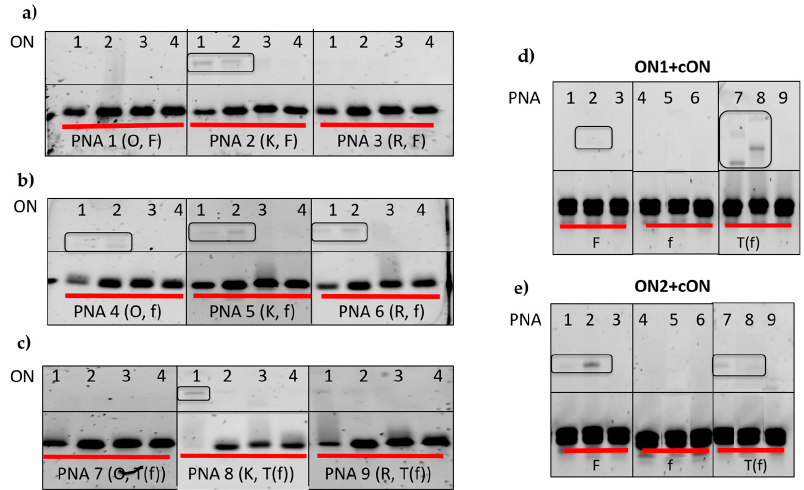
Figure 4. Denaturing polyacrylamide gel electrophoresis analysis of the crosslink experiments. ( a ) Crosslink experiment between ON 1 – 4 and PNA 1 – 3 (building block F ); ( b ) Crosslink experiment between ON 1 – 4 and PNA 4 – 6 (building block f ); ( c ) Crosslink experiment between ON 1 – 4 and PNA 7 – 9 (building block T ( f )); ( d ) Strand displacement experiment between ON 1 : cON duplex and PNA 1 – 9 ; ( e ) Strand displacement experiment between ON 2 : cON duplex and PNA 1 – 9 .